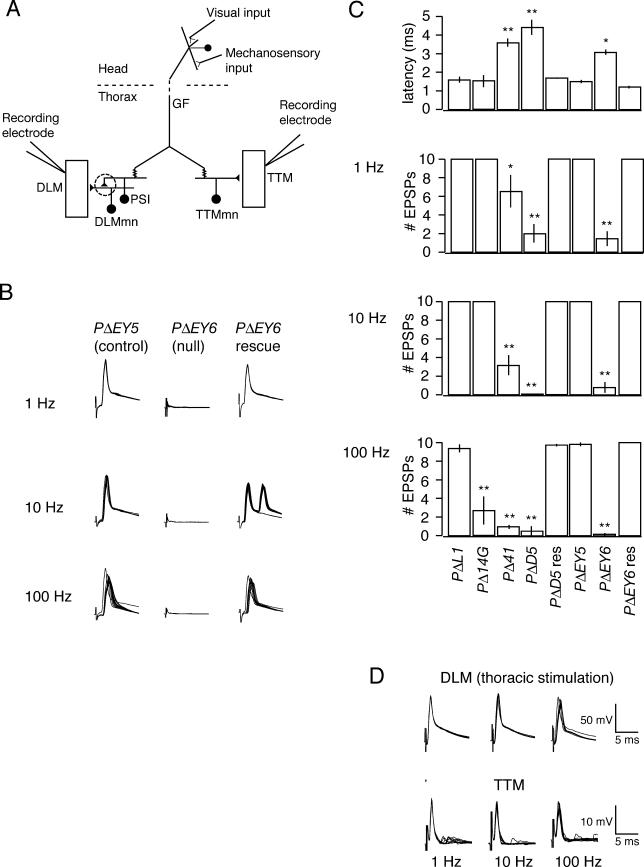
Defective Neurotransmission at the PSI-DLMmn Synapse inDα7 MutantsThe response of the DLMs to direct activation of the giant fiber is shown. The allelePΔL1 served as control forPΔ14G, PΔ41, andPΔD5, whilePΔEY5 served as control forPΔEY6. For rescue of thePΔD5 andPΔEY6 mutant alleles, experiments were performed in males with genotypePΔD5/Y; UAS Dα7/OK307 GAL4 andPΔEY6/Y; UAS Dα7/OK307 GAL4, respectively.(A) Schematic representation of the giant fiber circuit. Visual and mechanosensory input is transmitted via mixed electrical and chemical synapses to the giant fiber, which carries it to the thoracic ganglion. The TTMmn and PSI neurons are connected via electrical synapses to the giant fiber, and the PSI makes a chemical synapse onto the axon of the DLMmns (encircled).(B) Representative traces of intracellular recordings from DLM muscles forPΔEY5, PΔEY6, andPΔEY6/Y; UAS Dα7/OK307 GAL4.(C) The response of the mutant and control alleles to giant fiber stimulation is summarized in histograms. The top bar graph shows the average latency of the responses at 1 Hz. The second, third, and fourth bar graphs show the number of responses to ten stimuli at 1 Hz, 10 Hz, and 100 Hz respectively. Thep-values are as follows. For 1 Hz:PΔL1, n = 6;PΔ14G, 1 (n = 6);PΔ41, 0.04 (n = 7);PΔD5, 2 × 10−6 (n = 5);PΔD5/Y; UAS Dα7/OK307 GAL4, 1 (n = 4);PΔEY5, n = 5;PΔEY6, 2 × 10−6 (n = 9);PΔEY6/Y;UAS Dα7/OK307 GAL4, 1 (n = 5). For 10 Hz:PΔL1, n = 6;PΔ14G, 1 (n = 6);PΔ41, 2 × 10−6 (n = 7);PΔD5, 2 × 10−6 (n = 5);PΔD5/Y; UAS Dα7/OK307 GAL4, 1 (n = 4);PΔEY5, n = 5;PΔEY6, 2 × 10−6 (n = 9);PΔEY6/Y; UAS Dα7/OK307 GAL4, 1 (n = 5). For 100 Hz:PΔL1, n = 6;PΔ14G, 4 × 10−6 (n = 6);PΔ41, 2 × 10−6 (n = 7);PΔD5, 2 × 10−6 (n = 5);PΔD5/Y; UAS Dα7/OK307 GAL4, 0.9 (n = 4);PΔEY5, n = 5;PΔEY6, 2 × 10−6 (n = 9);PΔEY6/Y; UAS Dα7/OK307 GAL4, 0.7 (n = 5). All error bars represent SEM. Thep-values for latency measurements at 1 Hz are:PΔL1, (n = 5);PΔ14G, 1 (n = 6);PΔ41, 8.6 × 10−5 (n = 5);PΔD5, 3.2 × 10−5 (n = 2);PΔD5/Y;UAS Dα7/OK307 GAL4, 1 (n = 4);PΔEY5, (n = 5);PΔEY6, 0.02 (n = 3);PΔEY6/Y;UAS Dα7/OK307 GAL4, 1 (n = 5).(D) The top panel shows representative intracellular recording from the DLM with direct stimulation of its motor neuron at 1, 10, and 100 Hz. The bottom traces show representative recording from TTM with activation of the giant fiber.